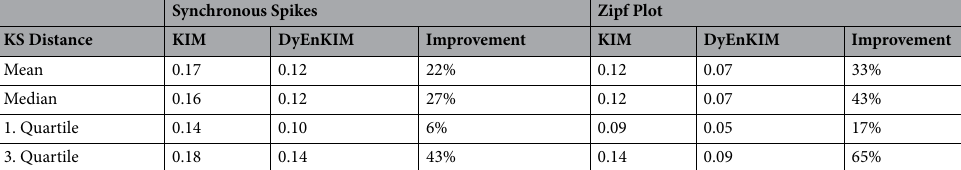
Table 1. Summary statistics of the Kolmogorov-Smirnov distances between the distributions of synchronous spikes and pattern frequency and the ones simulated with the KIM and DyEnKIM, taken on 297 experiments. The DyEnKIM consistently outperforms the KIM at reproducing higher-order quantities. We quantify KS KIM − KS DyEnKIM the improvement as the percentage difference between KS distances KS KIM , which is in favor of DyEnKIM in the vast majority of experiments.